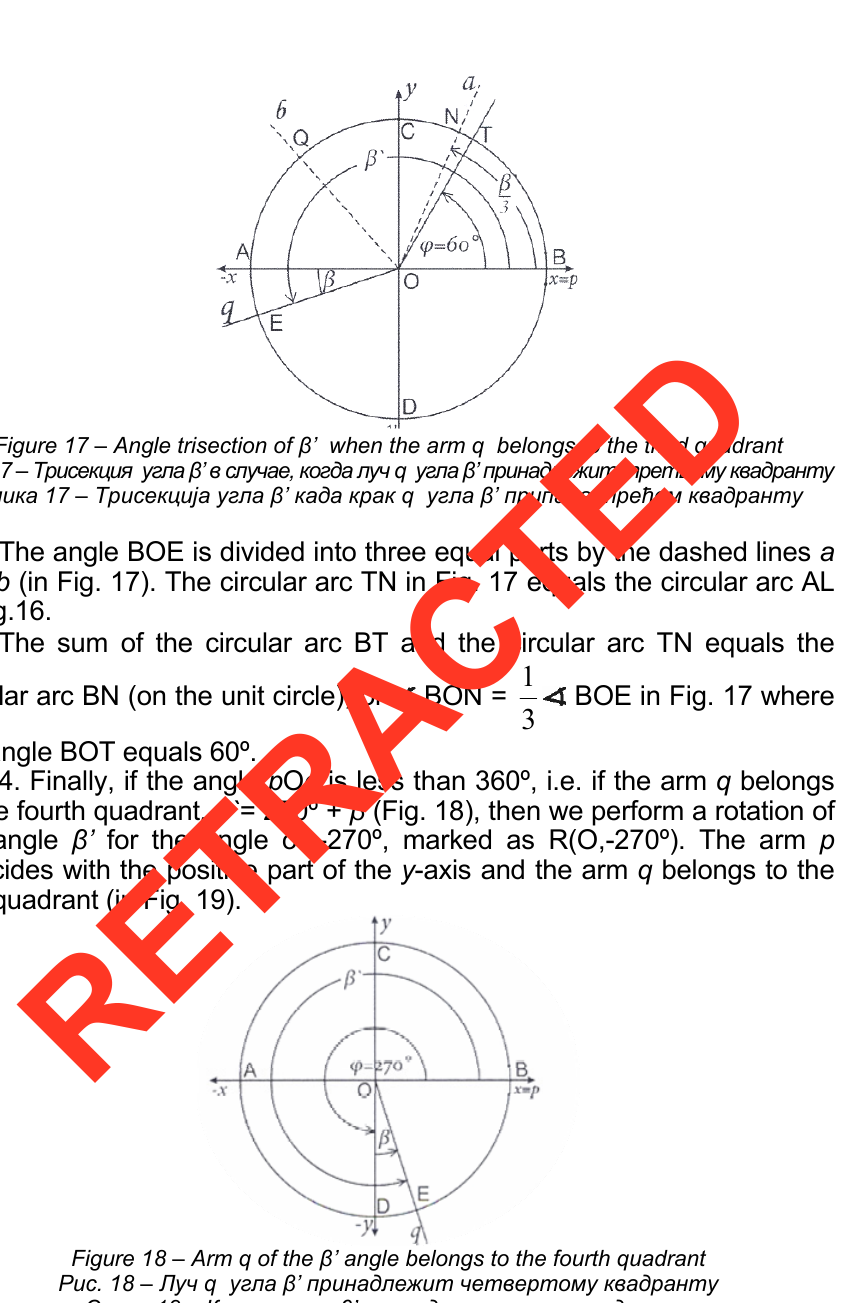
Figure 18 – Arm q of the β ’ angle belongs to the fourth